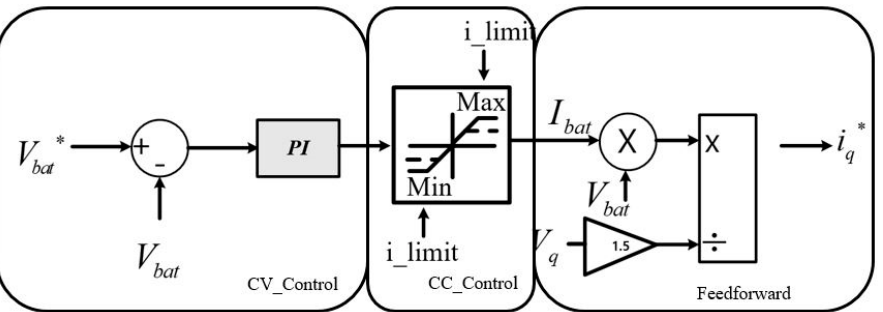
Figure 14. Block diagram for the charging control mode of a power compensator.